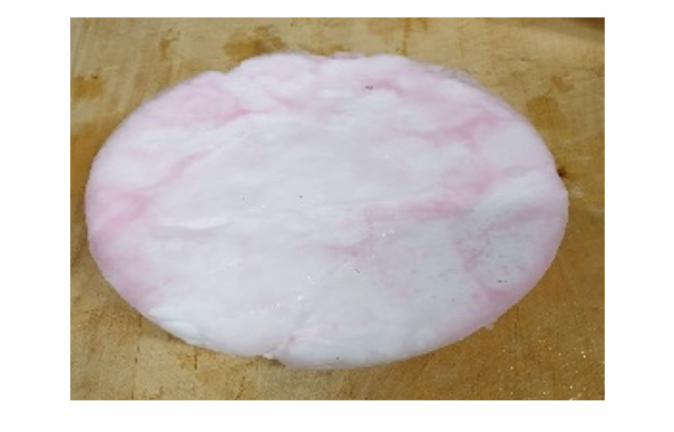
Figure 8. Hydrate pellet obtained from pressing after hydrate formation (at 37.5 bar and 3 °C) in the water–sucrose–betanin model